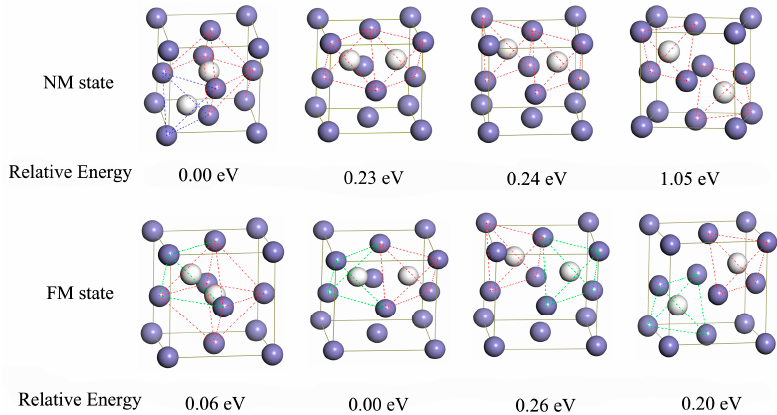
Figure A1. The structures of interstitial compounds of Al-free austenite containing two hydrogen atoms and the relative energy (eV) in NM and FM states.